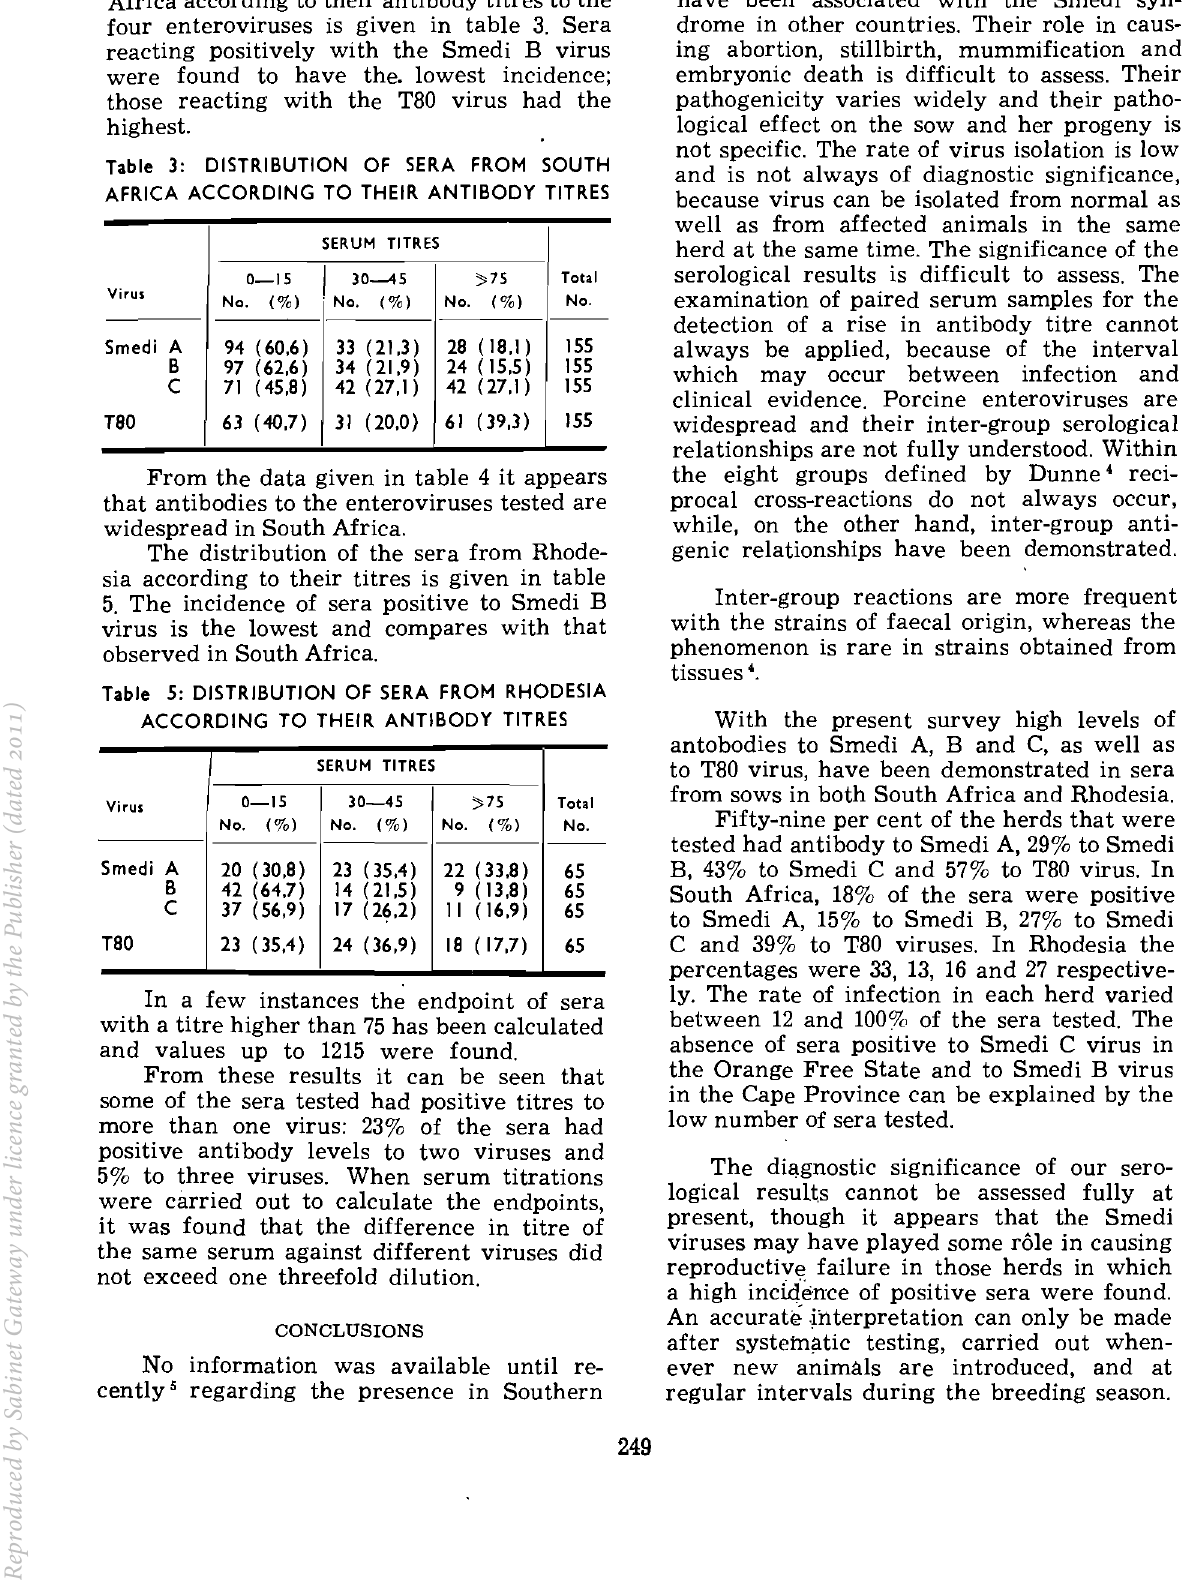
Table 3: DISTRIBUTION OF SERA FROM SOUTH AFRICA ACCORDING TO THEIR ANTIBODY TlTRES